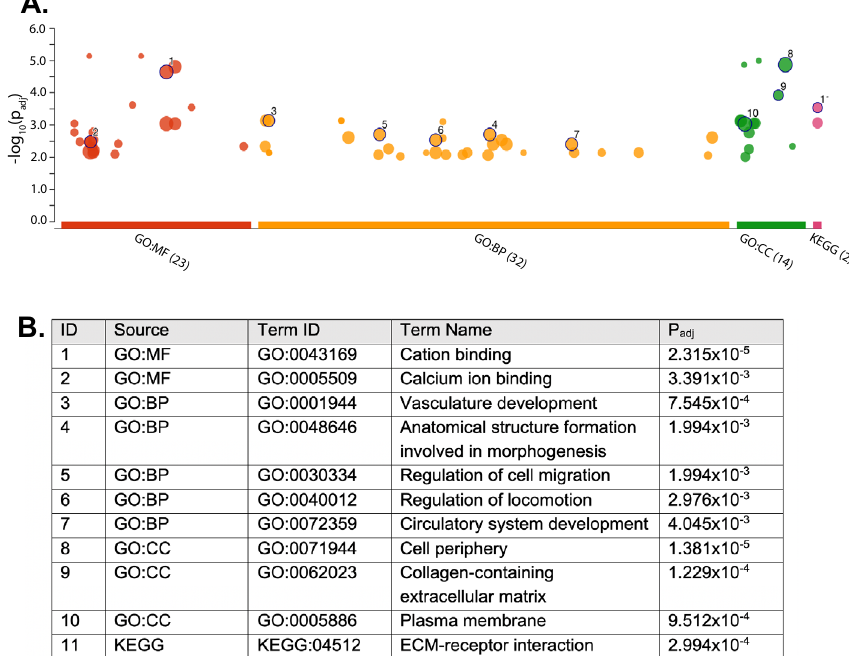
Figure 3. Gene enrichment analysis: functional terms and KEGG pathways. ( A ) g:Profiler Manhattan plot. The x axis shows the functional terms (term size greater than 50), grouped and colour-coded by data source (red = GO molecular function, orange = GO biological process, green = GO cellular component, pink = KEGG database). The position of terms in the plots is fixed and terms from the same gene ontology branch are close to each other. The size of circles shows the corresponding term size. Numbers correspond to the terms in the table below; the full list of terms is available in Supplementary Table 3. ( B ) Legend gene enrichment analysis. The table shows the ID referred to the Manhattan plot above, source database, term ID, term name, adjusted p values after FDR correction. See Supplementary Table 3 for the full list of